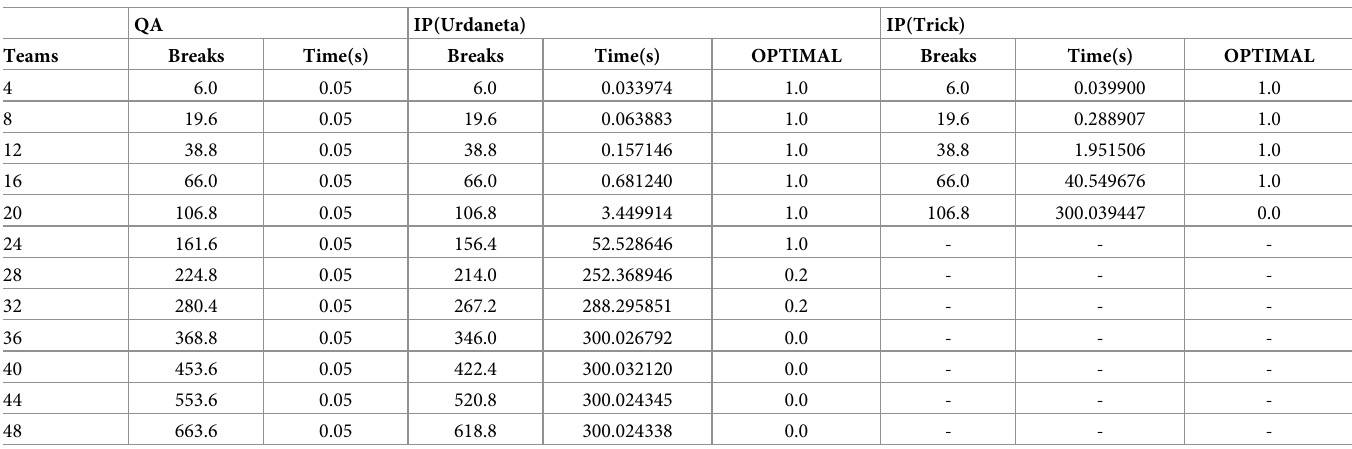
Table 6. QA vs. IP in MDRRTs.